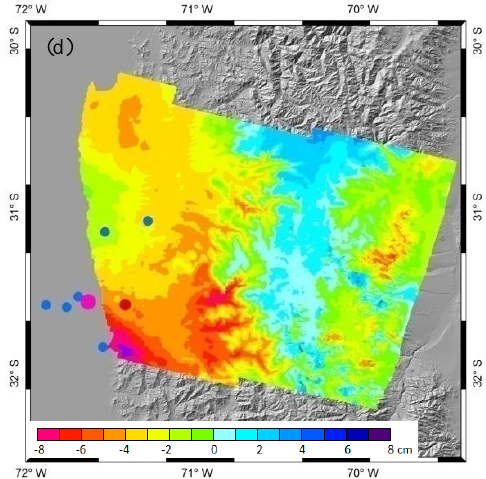
Figure 5. (a) and (b) The post-seismic interferogram from SAR image pair 3 (1011_1023) and its corresponding unwrapped interferometric displacement. (c) and (d) The post-seismic interferogram from SAR image pair 4 (1011_1104) and its corresponding unwrapped interferometric displacement. A fringe indicates 28cm LOS displacement. Big pink dot is the epicenter of Mw8.3 mainshock, other color dots show aftershock with implication same as in